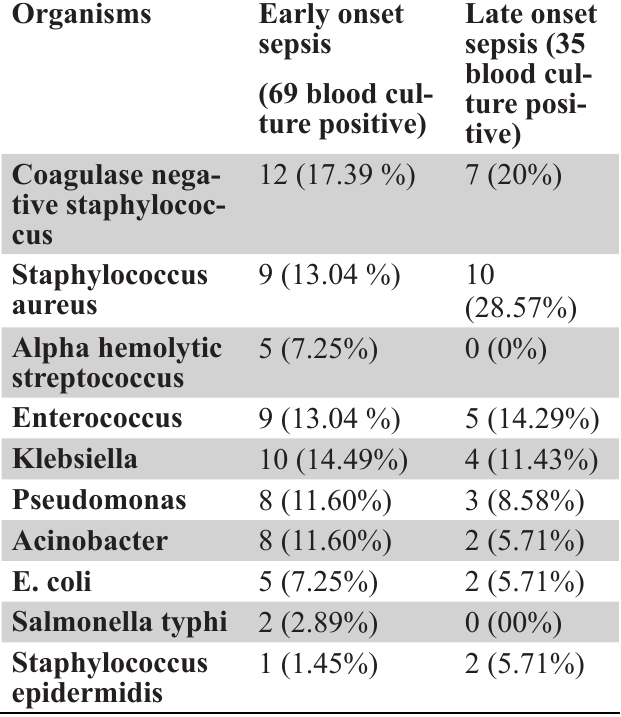
Table 2. Association of organisms with the onset of sepsis.